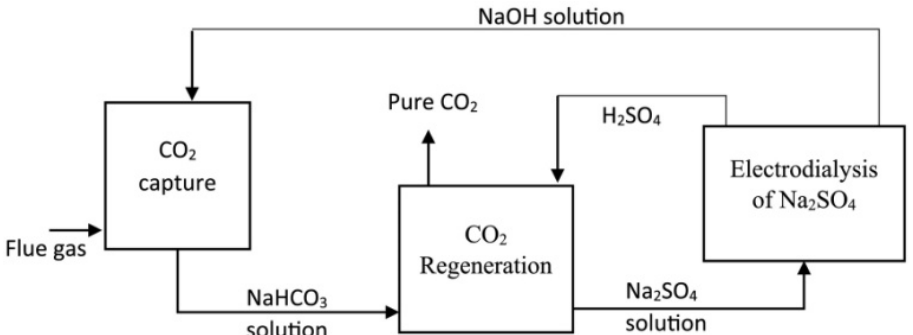
Figure 14. Diagram of continuous CO 2 capture and regeneration with EDBM system. CO 2 is captured with NaOH solution and then regenerated by reacting with H 2 SO 4 ; the resultant Na 2 SO 4 solution is subjected to electrodialysis with a bipolar membrane to produce acid and base. The base (NaOH) is circulated back to capture additional CO 2 [84].